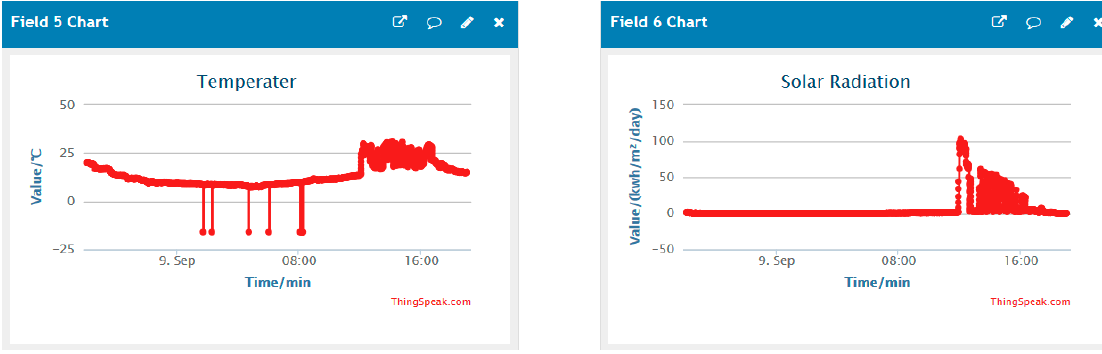
Figure 19. Temperature and solar radiation in one day.